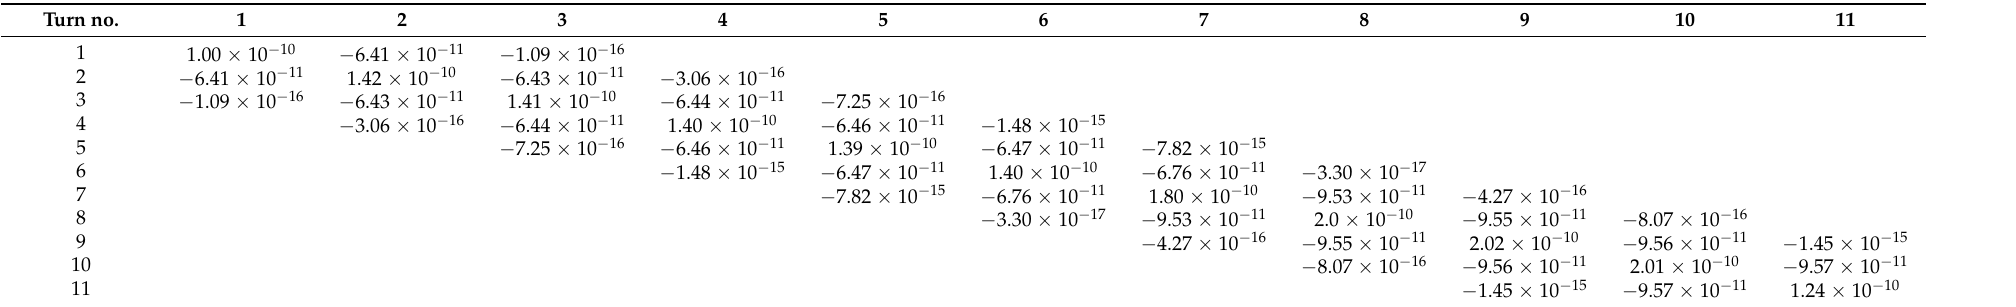
Table 2. The maxwell capacitance matrix (in F) resulting from FEM simulations.